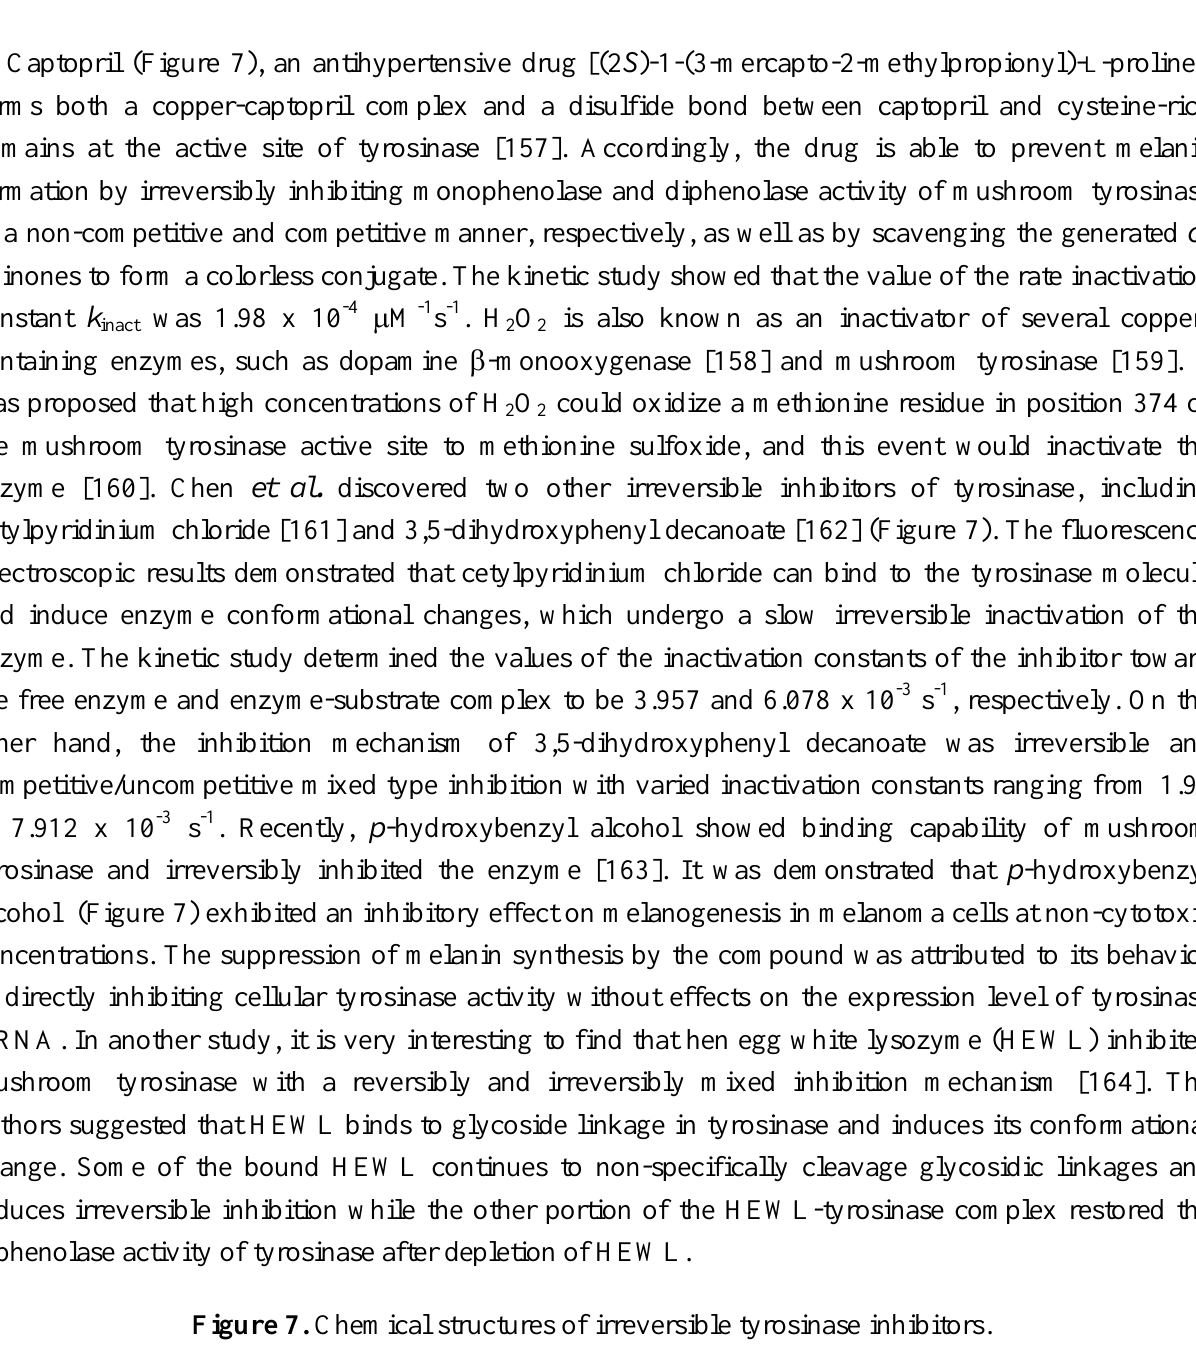
Figure 7. Chemical structures of irreversible tyrosinase